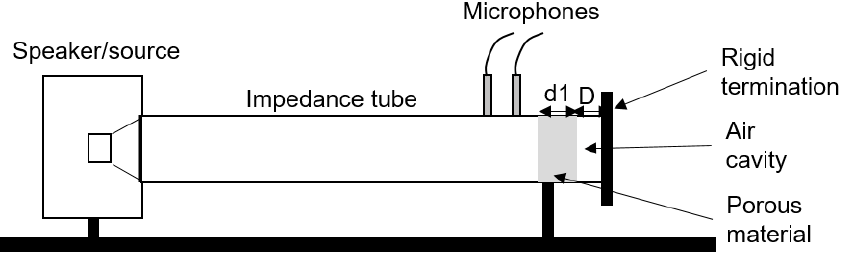
Figure 6. Schematical representation of the experimental two-cavity method (retrieved from